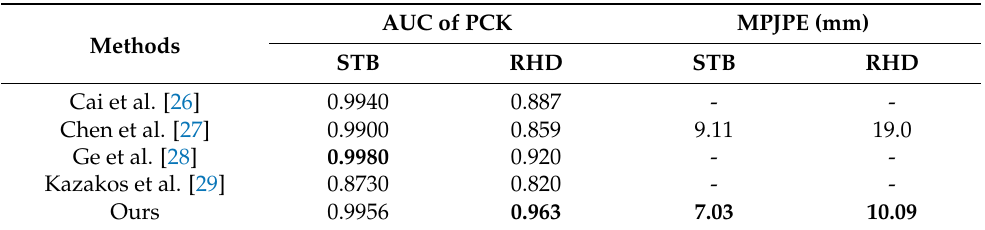
Table 1. Comparison with related works on the RHD and STB datasets. ‘-’ denotes that the original paper did not report this data. The bold numbers indicate optimal results.